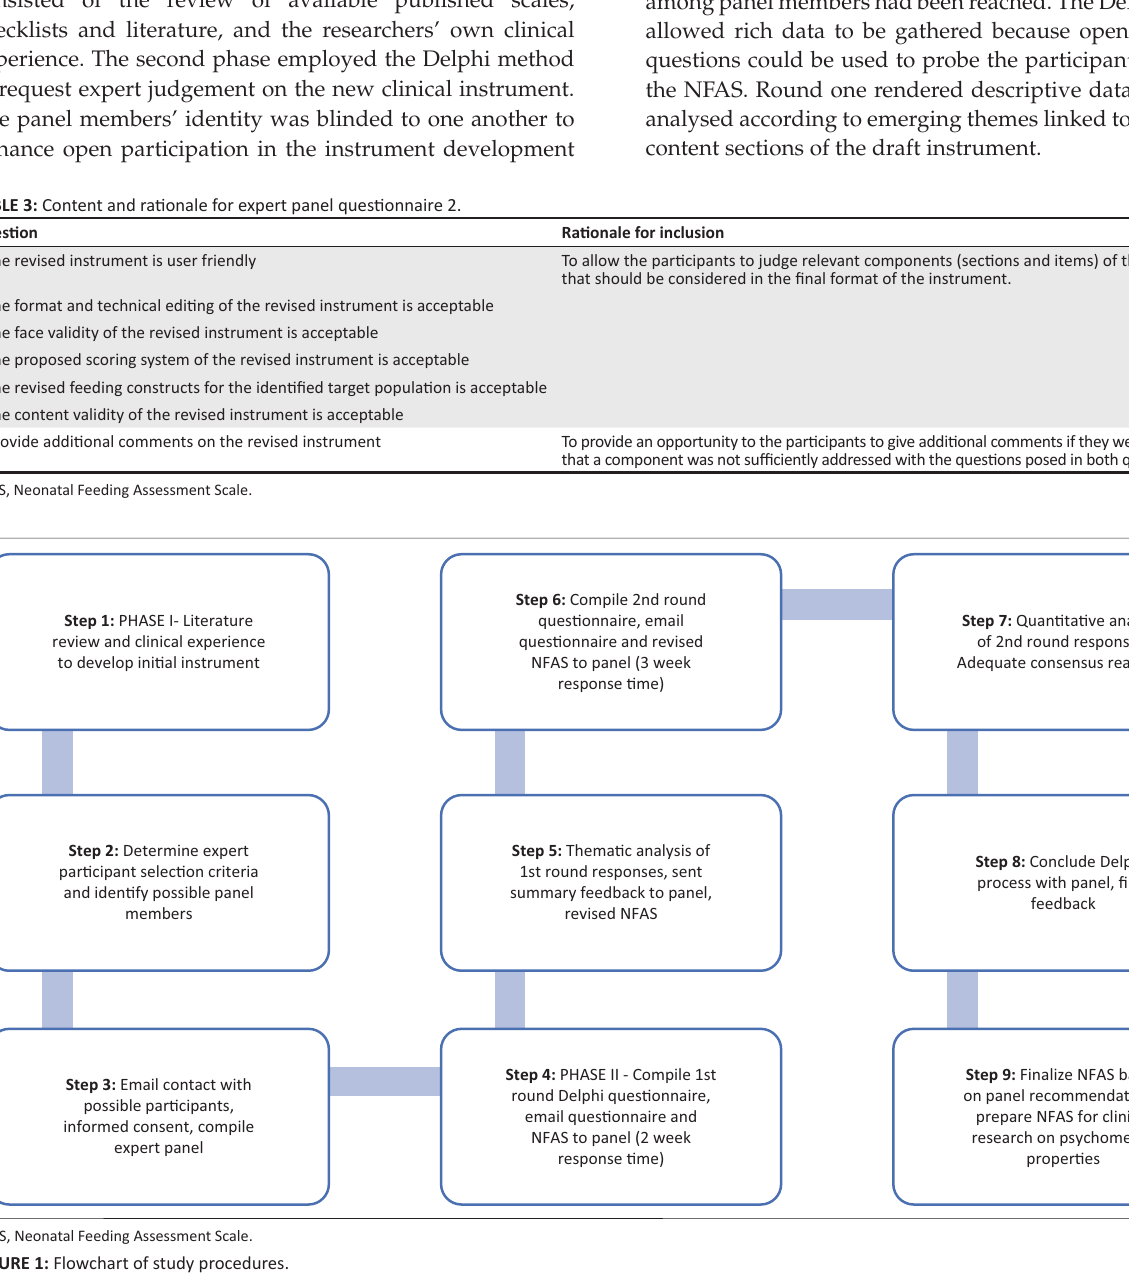
FIGURE 1: Flowchart of study